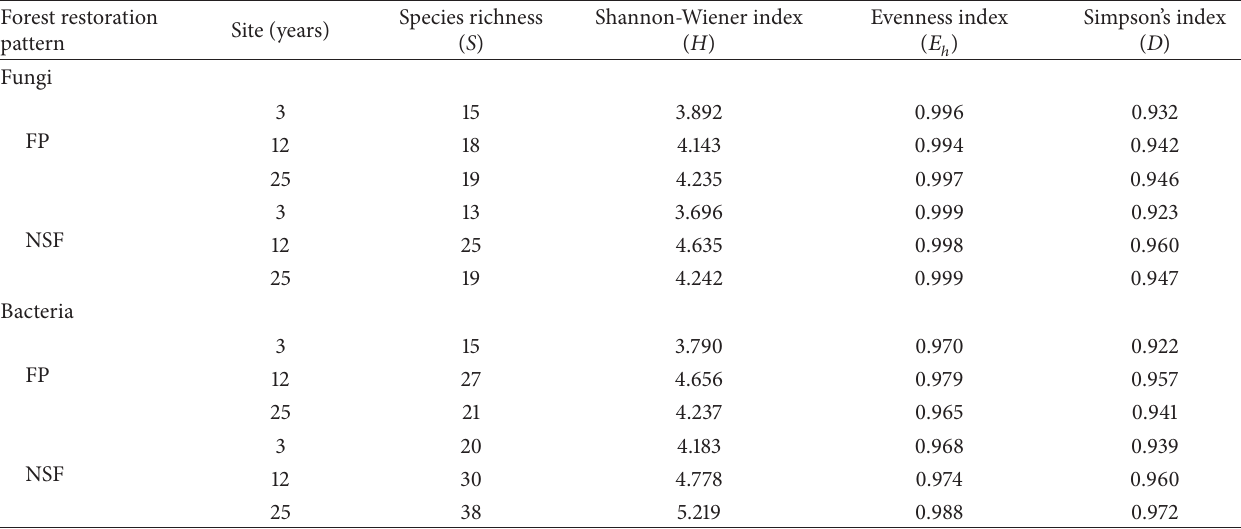
Table 2: Richness ( 𝑆 ), Shannon-Wiener index ( 𝐻 ), Evenness index ( 𝐸 ℎ ), and Simpson index ( 𝐷 ) of fungal and bacterial communities in the rhizosphere of Pinus tabulaeformis . FP represents forest plantation, and NSF represents natural secondary forest. Forest